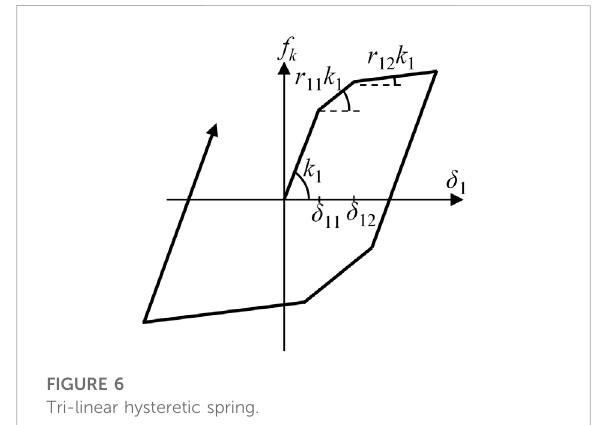
FIGURE 6 Tri-linear hysteretic